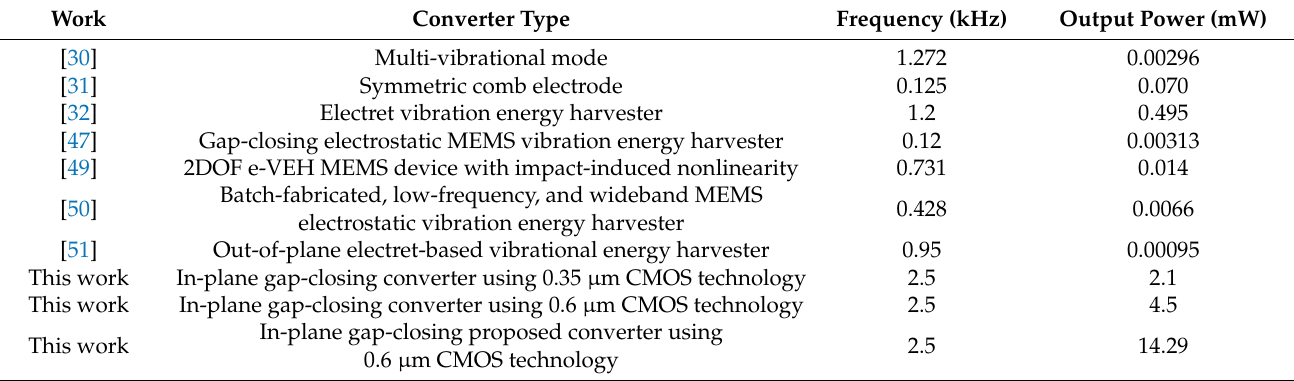
Table 4. Performance parameters comparison of different electrostatic